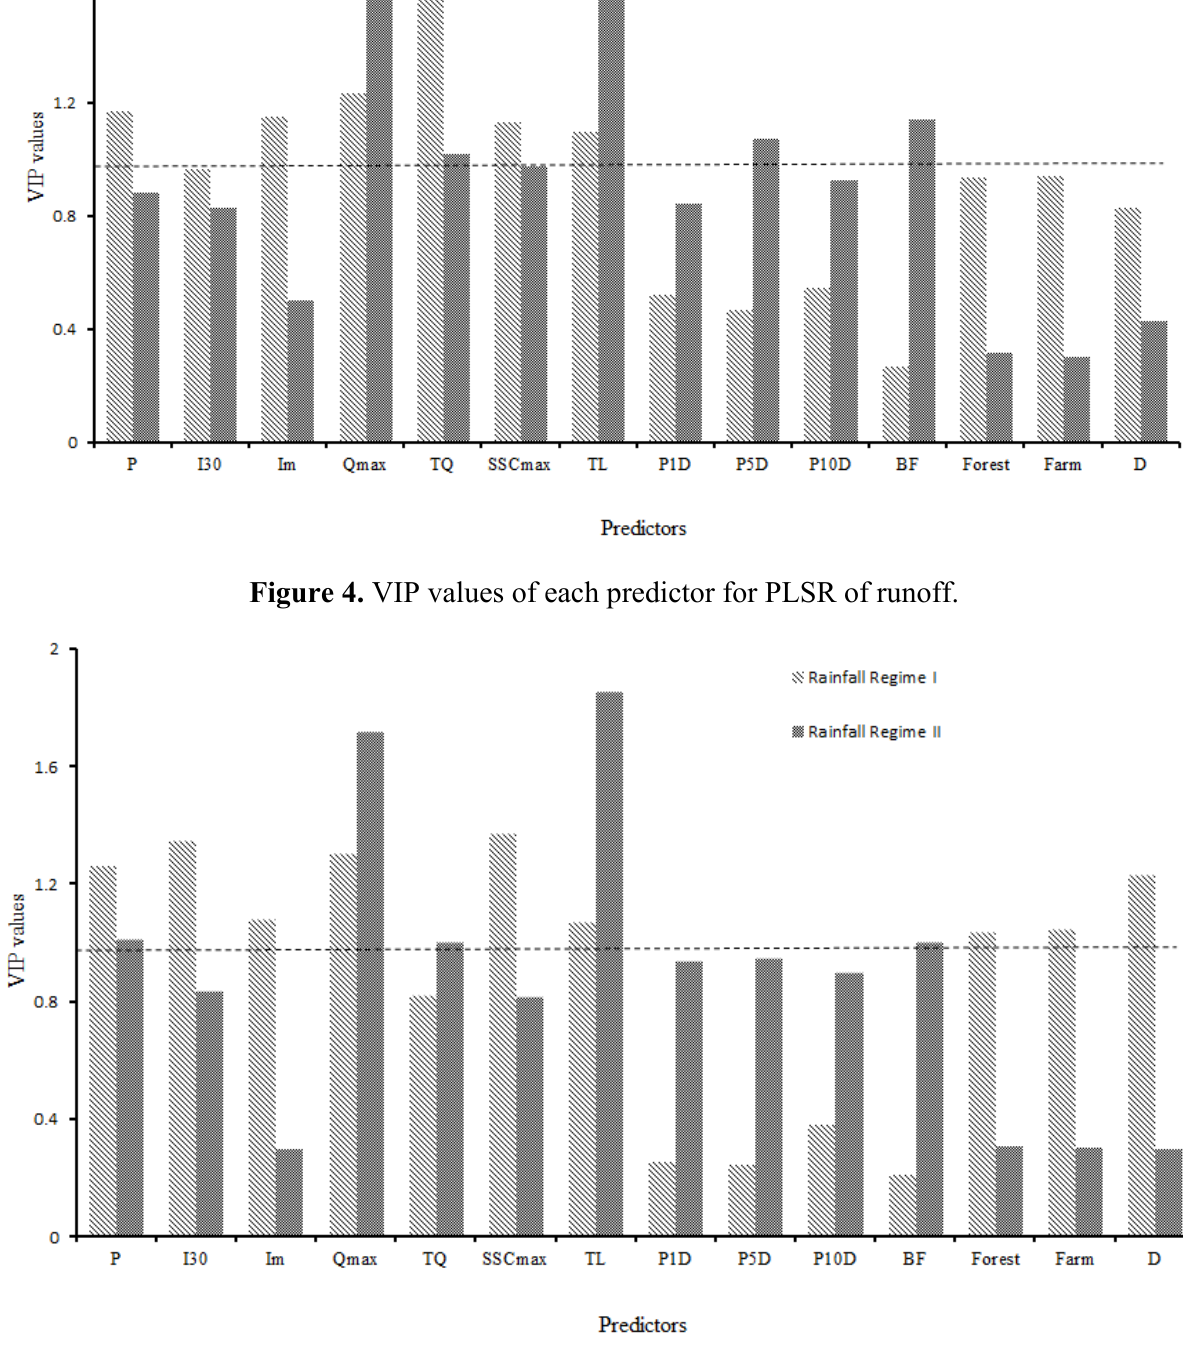
Figure 5. VIP values of each predictor for PLSR of sediment